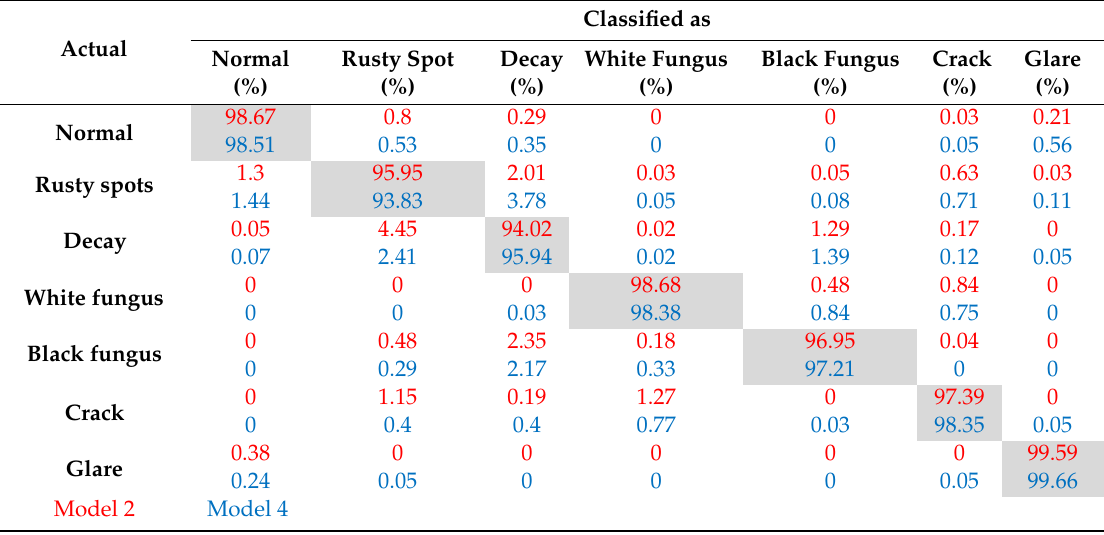
Table 3. Confusion matrices of the classification models with the use of linear scan dataset.